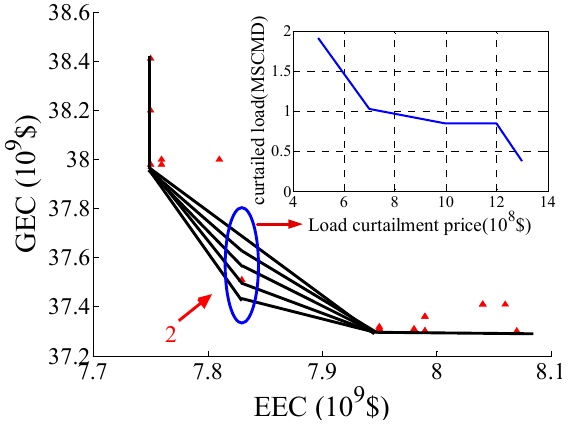
Figure 8. Effect of load curtailment price on point 2.